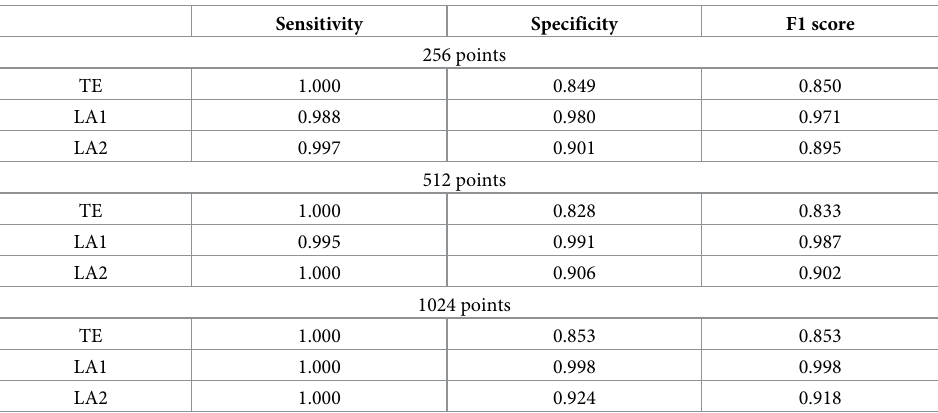
Table 2. Sensitivity, specificity and F1 score values obtained from Model